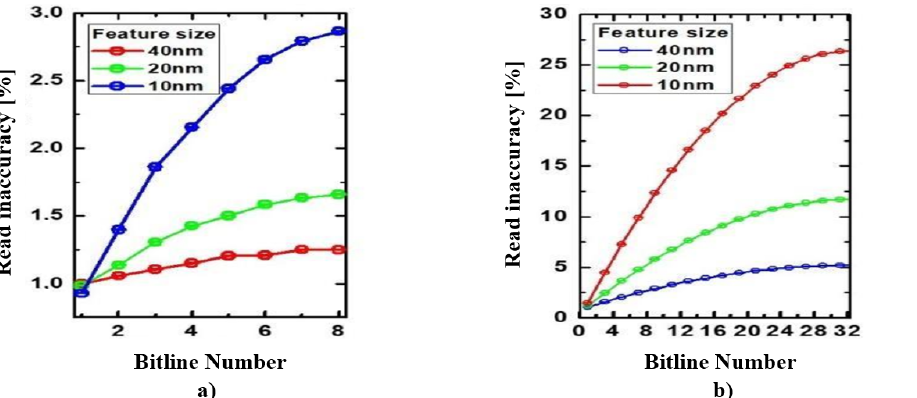
Figure 6. An example of accuracy deviation on RRAM devices (40 nm, 20 nm, 10 nm), effected by IR drop and sneak path, in which Bitline number represents the number of channels on each layer, and read inaccuracy is accuracy deviation: ( a ) accruacy deviation with a number of bitline from 1 to 8; ( b ) accuracy deviation with a number of bitline from 1 to